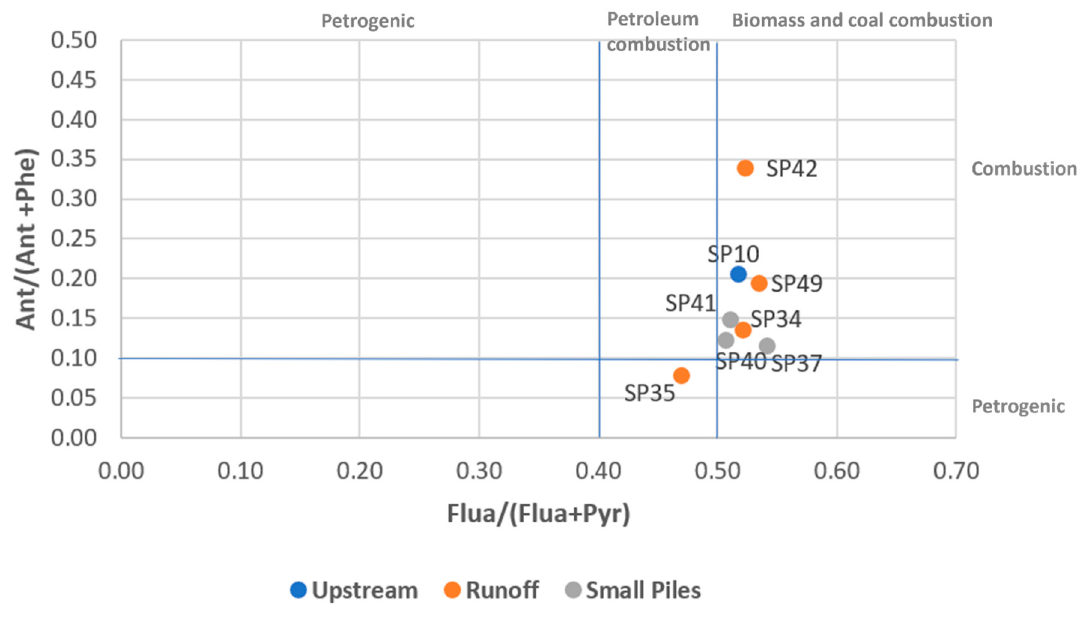
Figure 11. Cross plots for the isomeric ratios of Ant/(Ant + Phe) vs. Flua/(Flua + Pyr) on the topsoils of the surrounding area of the of São Pedro da Cova mine.